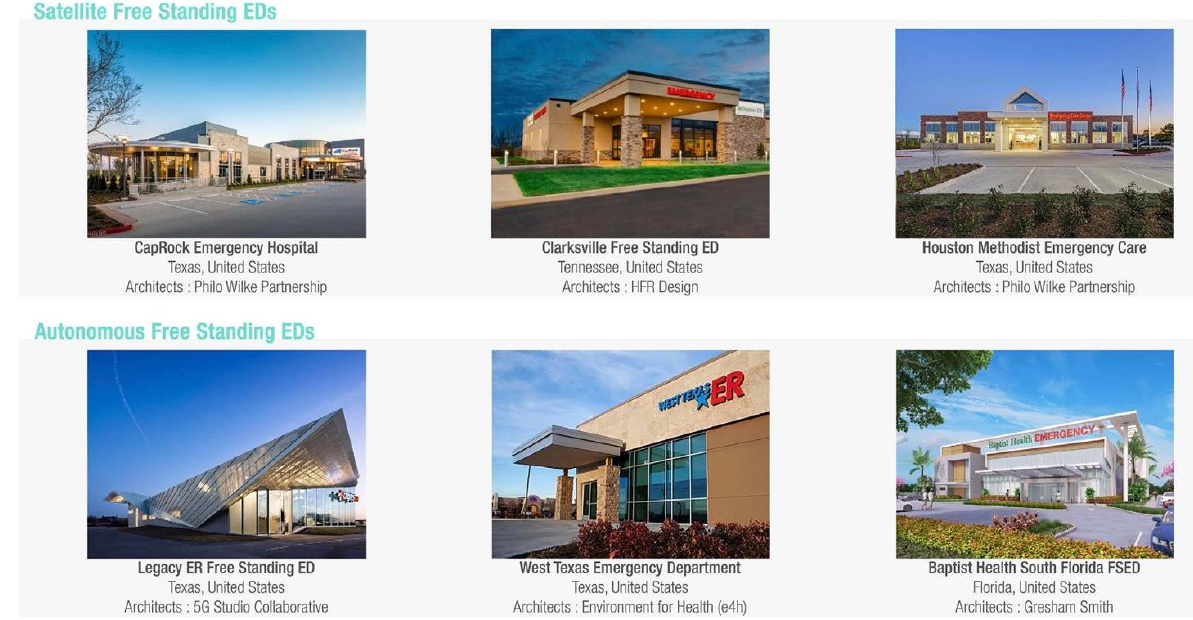
Figure 6. FSED Case studies Analysis.